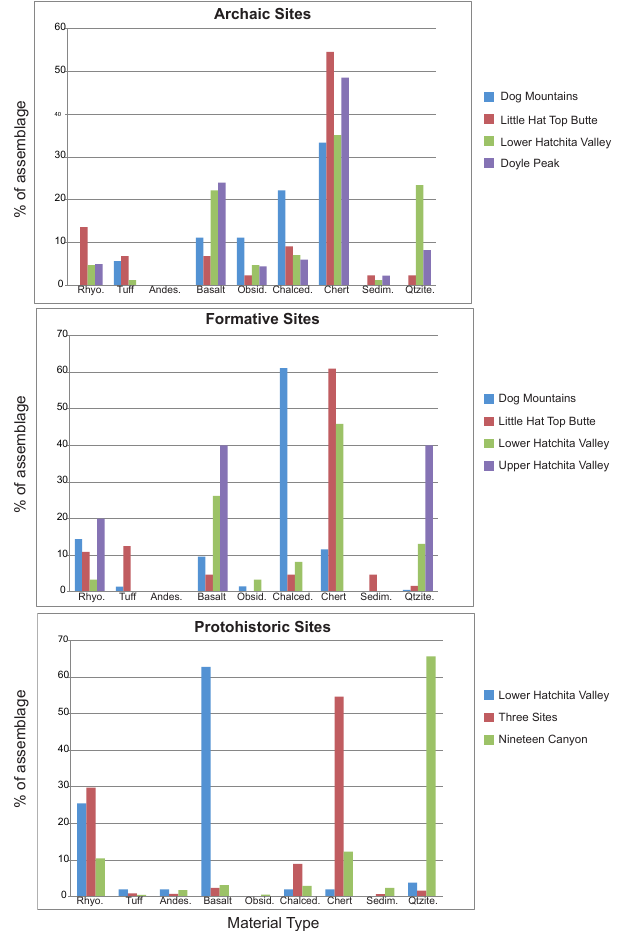
Fig. 4. Histograms by Period designation showing materials used in each site cluster. Some materials with low counts (i.e., pris- matic quartz) were omitted from the histogram. Rhyo. = rhyo- lite, Andes. = andesite, Obsid. = obsidian, Chalced. = chalcedony, Sedim. = sedimentary rock, Qtzite =